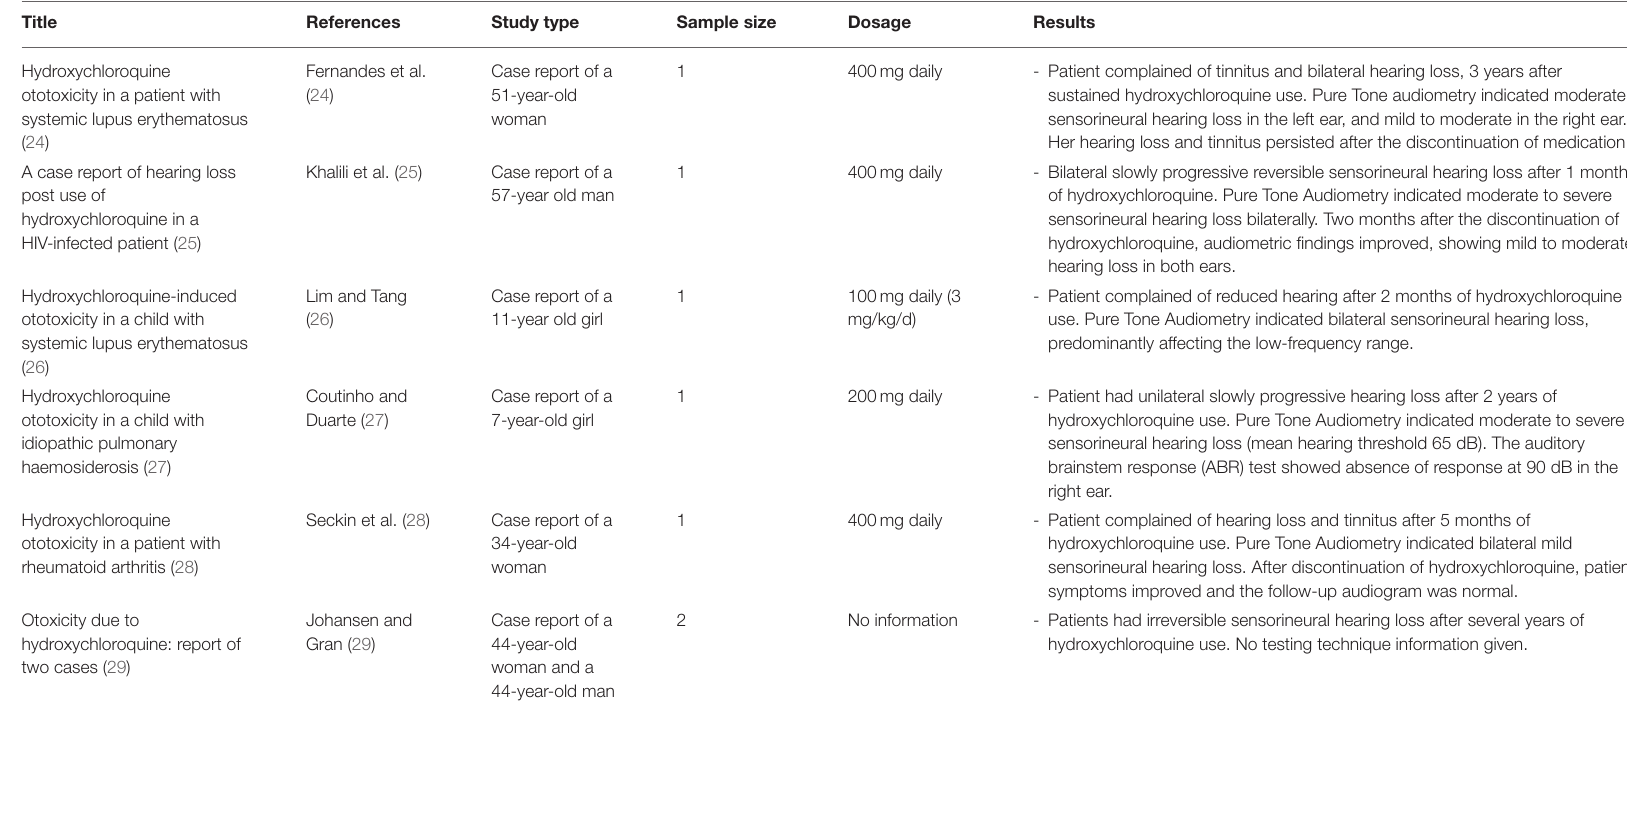
TABLE 2 | Hydroxychloroquine